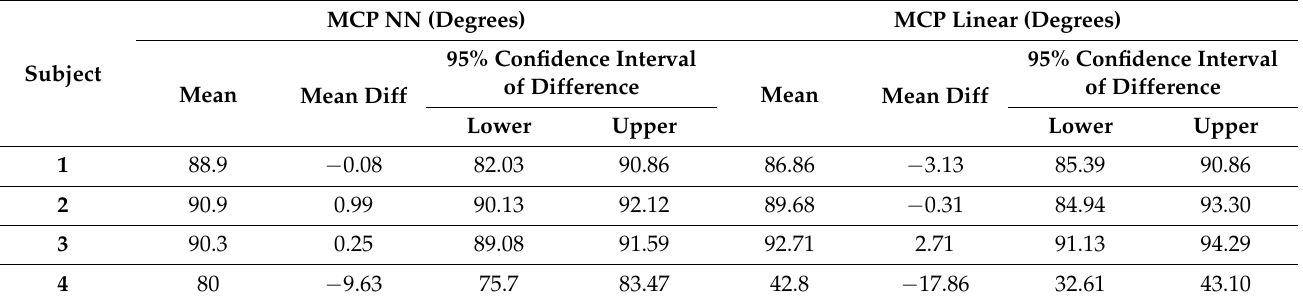
Table 6. Average NN and linear comparisons for MCP joints.